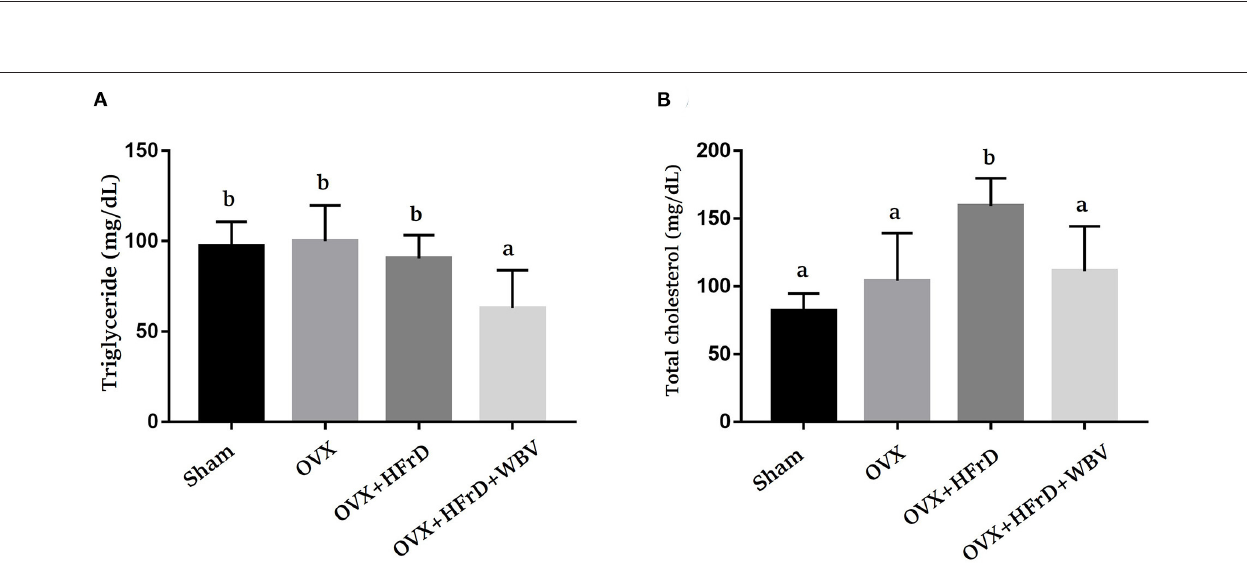
Frontiers in Nutrition | www.frontiersin.org